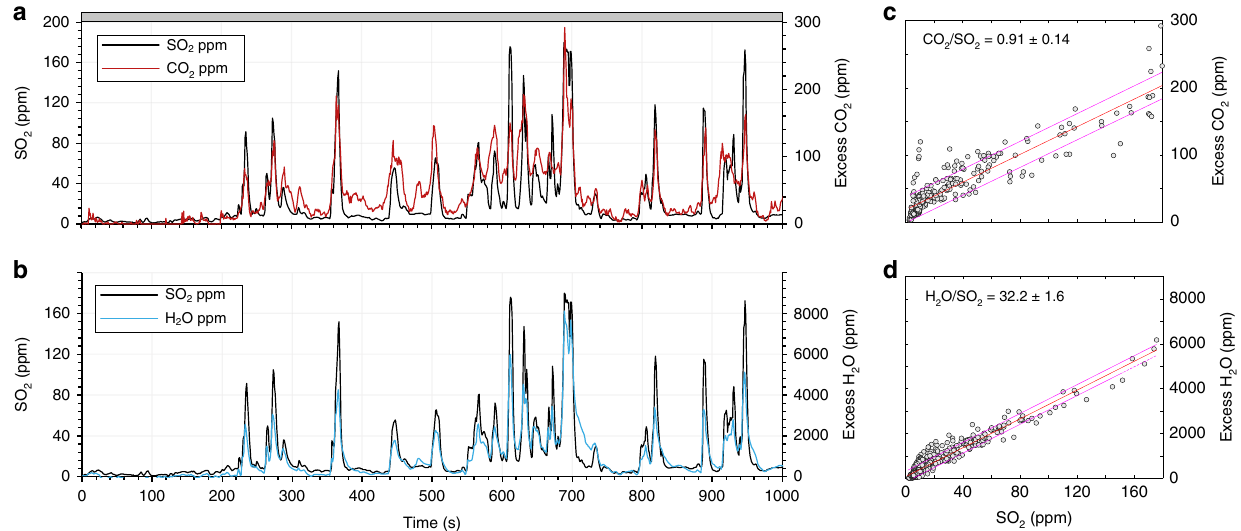
Fig. 4 Molar gas compositions for UAS over fl ight on 07/06/18. Molar gas composition data for an UAS over fl ight on 07/06/18 during passive degassing from the central vent area (C), showing gas concentration timeseries for a SO 2 and CO 2 , b SO 2 and H 2 O and c , d the corresponding scatterplots, showing the least squares regression and 95% con fi dence intervals. Excess refers to the concentration of the gas species of interest above background, which was determined from clean air measurements made outside of the plume where SO 2 = 0. Gas molar ratios correspond to the gradient of the regression line shown. The fl ight path comprised horizontal transects through the plume around 20 m downwind of the vent. Each peak indicates passage through the plume, with troughs indicating positions outside of the plume (e.g. where SO 2 values = 0).